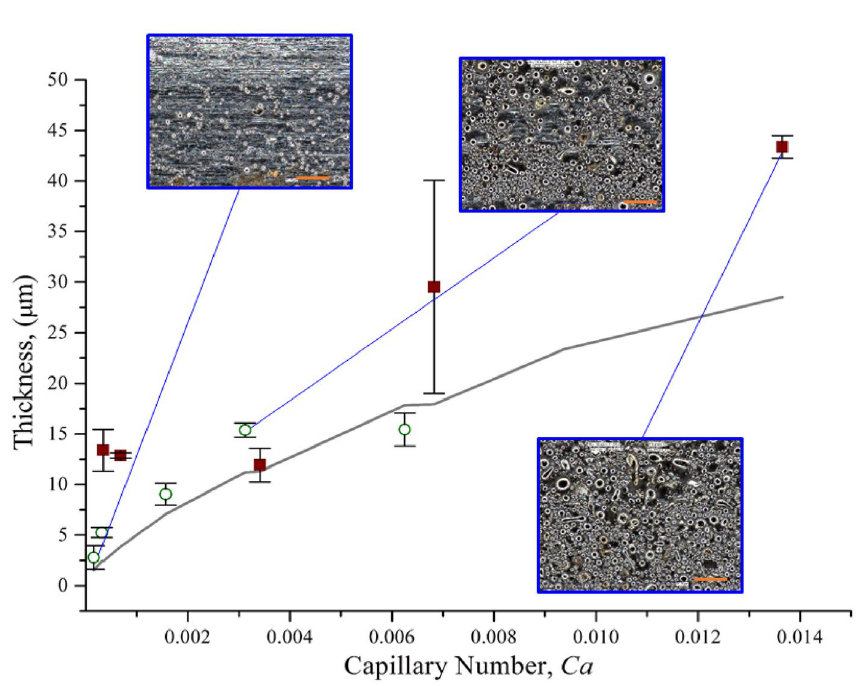
Figure 10. Thickness as a function of capillary number for different withdrawal velocities (0.5 to 20 mm/s). The grey line corresponds to the LLD law thickness. The hollow circle is for composition 11 (6.5% binder and 35% powder) and the solid square is for composition 21 (10.5% binder and 35% powder). The scale bar is 50